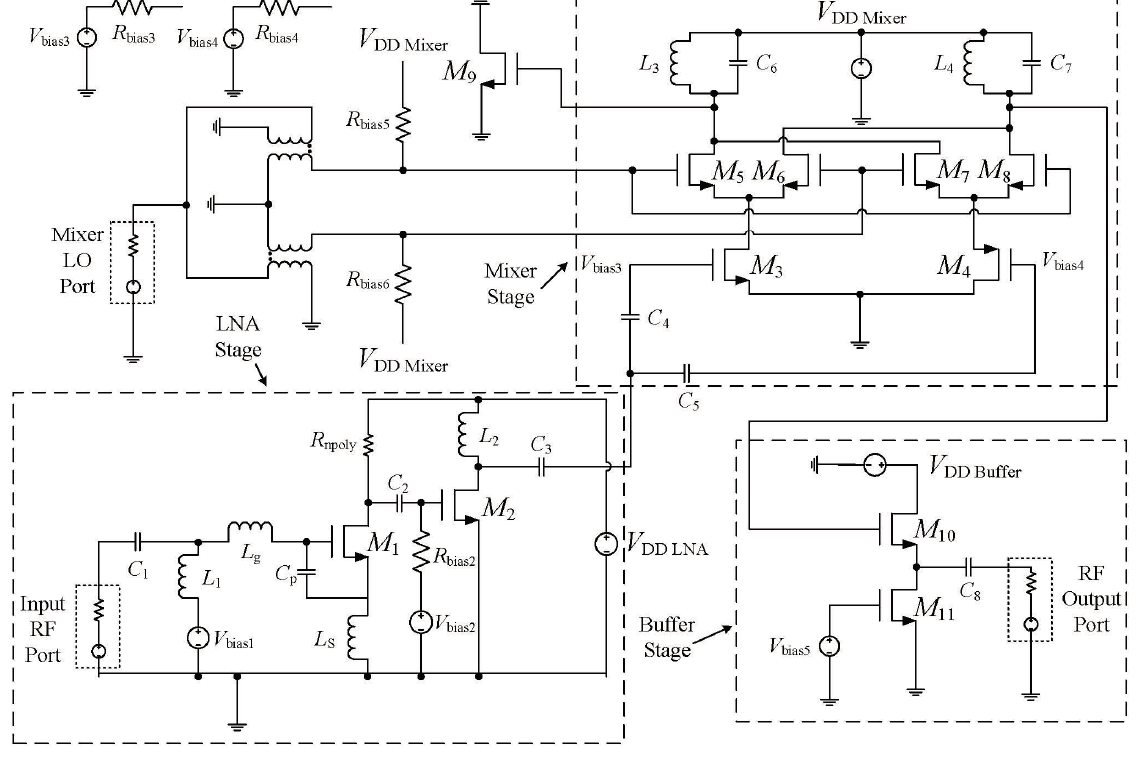
Figure 2. Schematic of the receiver